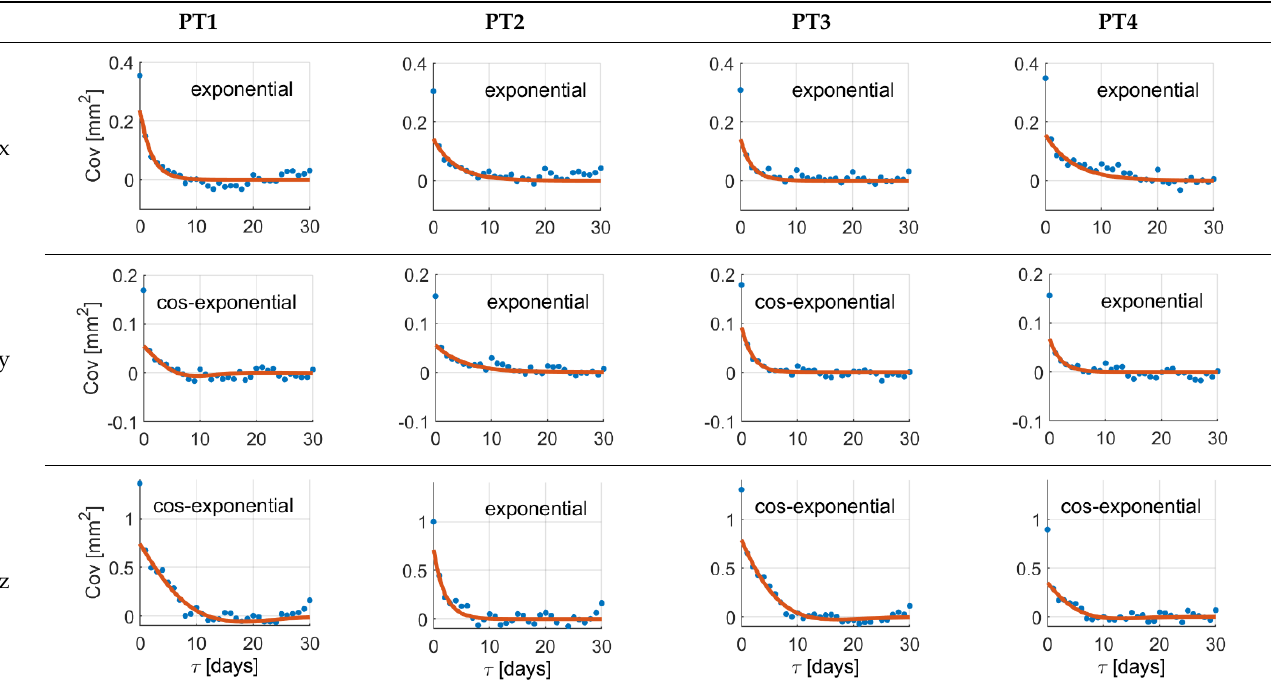
Table 2. Estimated covariance models for all the components at all the points. Red lines represent the estimated models, while blue dots the empirical covariance functions. Units are days for the 𝜏 axis (abscissa) and mm 2 for the covariance axis (ordinate). The 𝜎 𝜂2 is the difference between the red curve and the blue dot at the origin ( 𝜏 = 0 ).